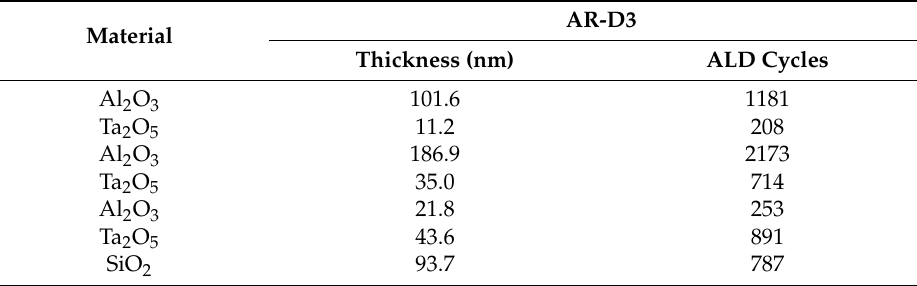
Table 4. Designed layer thickness and necessary ALD cycles of AR coating on B270.